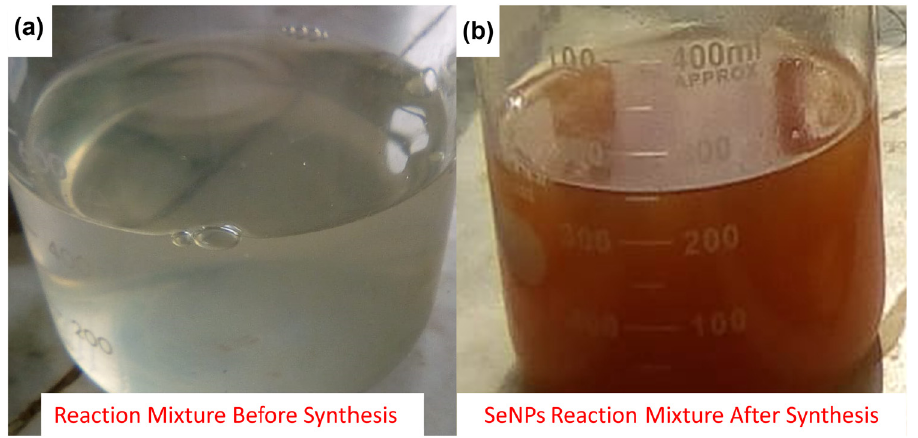
Figure 1: ( a ) Change in the color of reaction mixture before synthesis and ( b ) after the synthesis of